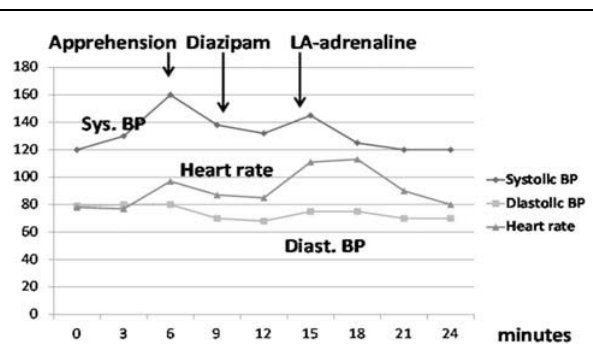
Changes of blood pressure and heart rate with local anesthesia lidocaine 2% with 1 : 20 000 adrenaline. BP, blood pressure; LA, local